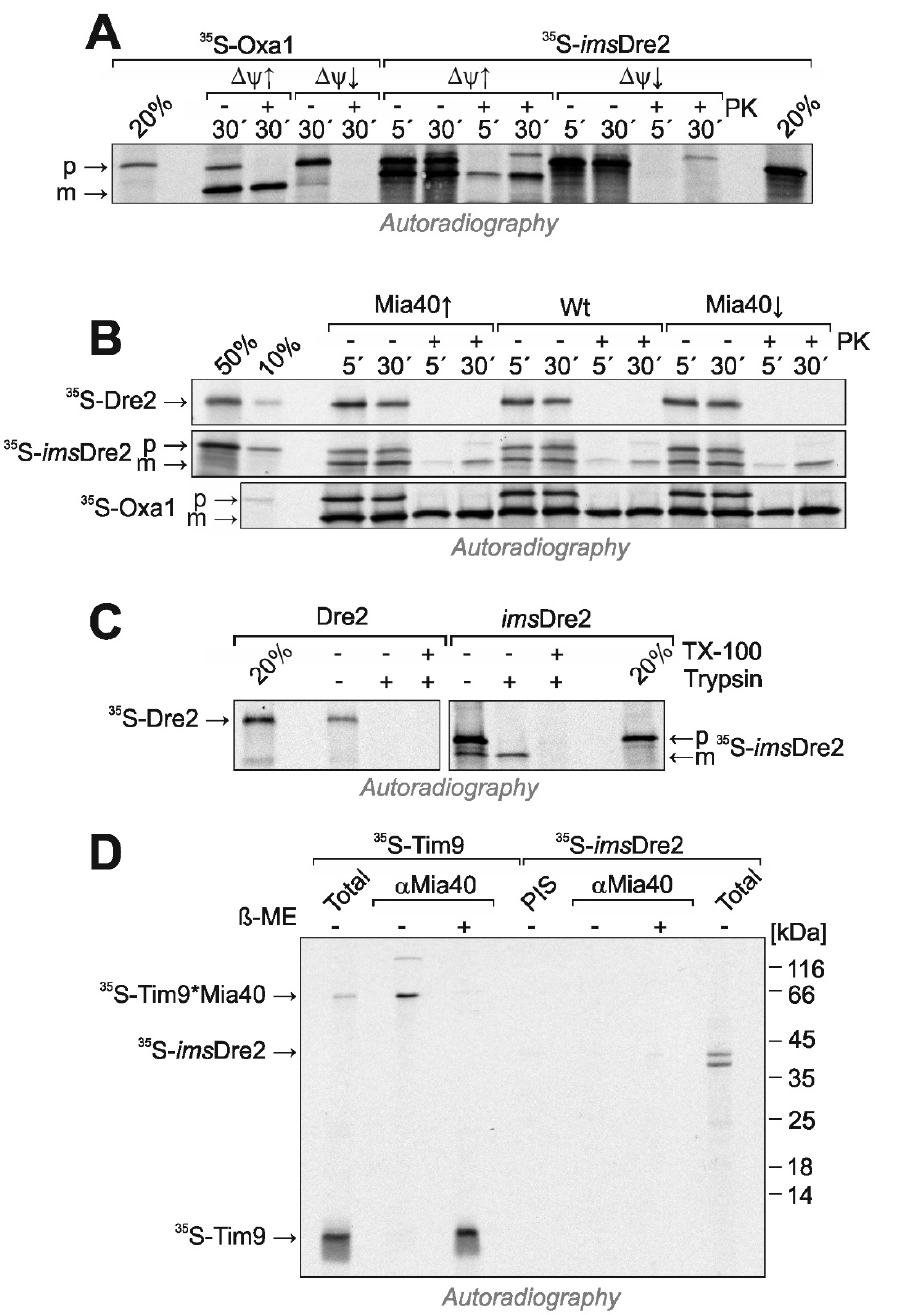
FIGURE 6: ims Dre2, but not Dre2, can be imported into iso- lated mitochondria. (A) Oxa1 and ims Dre2 were synthesized in reticulocyte lysate in the pres- ence of 35 S-methionine. The